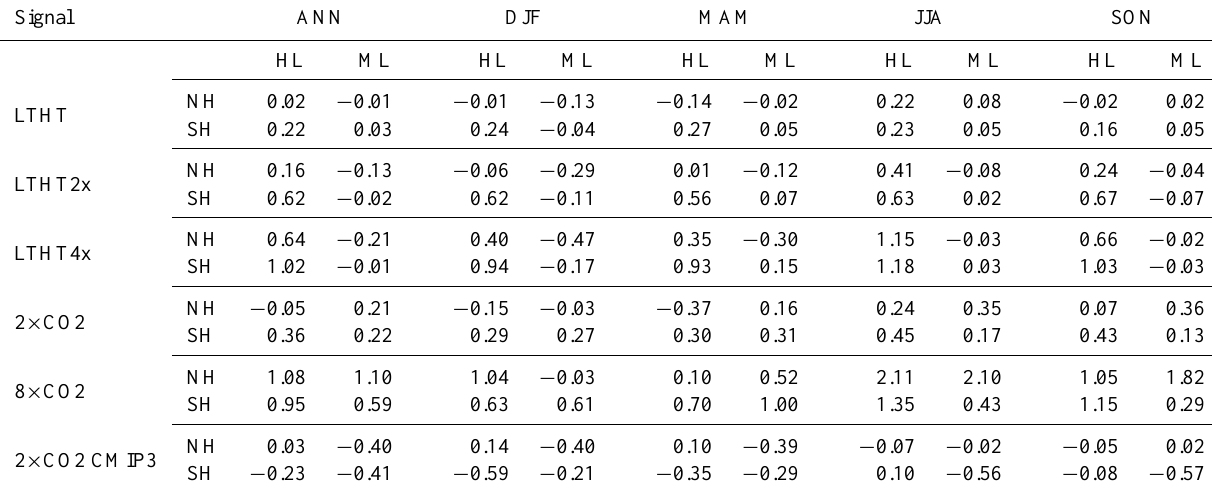
Table 7. Tropospheric (850–300hPa) warming amplification factors for high-latitudes (HL; 60–90 ◦ minus 30–60 ◦ ) and mid-latitudes (ML; 30–60 ◦ minus 0–30 ◦ ) for the global warming experiments. Factors are based on log-pressure and area weighting. Also included are the corresponding values based on the ensemble mean of 12 CMIP3 2 × CO2 experiments. Units are K. Signal